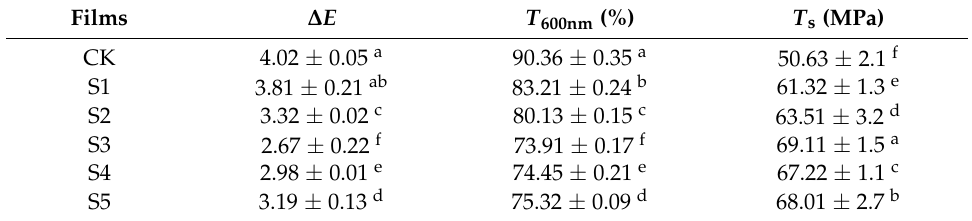
Different superscripts indicate a significant difference ( p < 0.05) within the